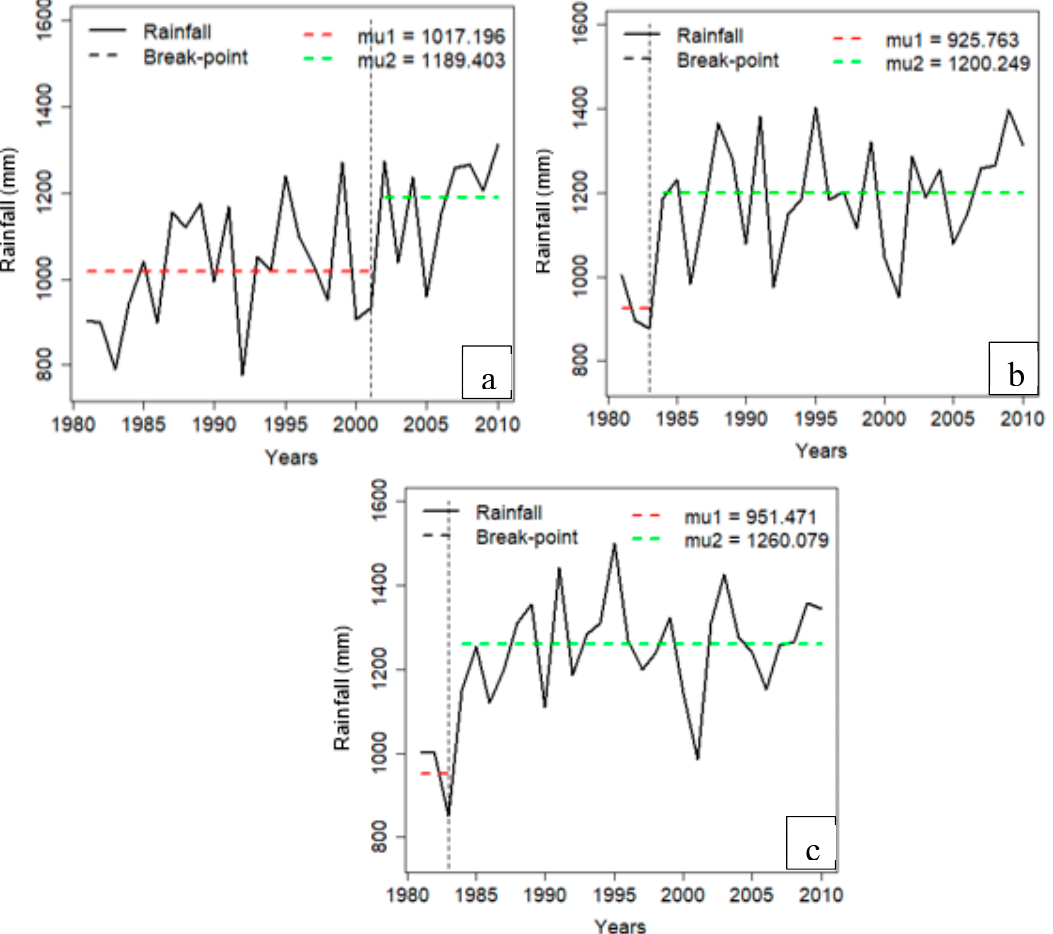
Figure 3. Standardized Normal Homogeneity (SNH) test on observed annual rainfall time series in the south ( a ), center ( b ) and north ( c ).